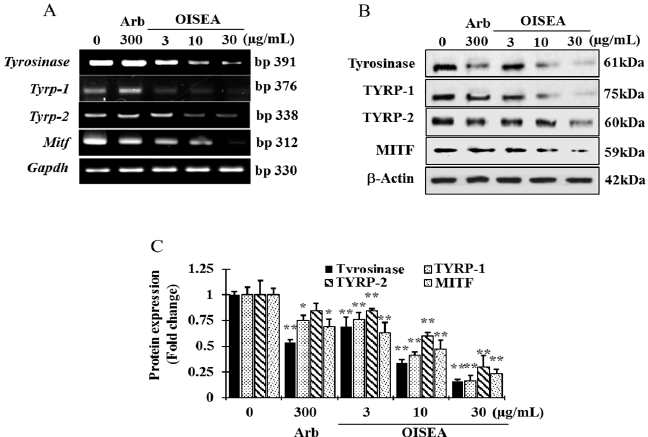
Figure 4. Effect of OISEA on the levels of melanogenesis related mRNA and proteins in melan-a cells. ( A ) Cells (5 × 10 5 cells/mL) were cultured for 24 h; the medium was replaced with fresh medium containing the indicated concentration of OISEA or arbutin for 24 h, and the mRNA was extracted using TRIzol. mRNA expression was analyzed by reverse transcription-polymerase chain reactions. ( B ) Cells (5 × 10 5 cells/mL) were cultured for 24 h; the medium was replaced with fresh medium containing the indicated concentrations of OISEA or arbutin for 3 days. Total cell lysates were extracted and assayed by Western blotting using antibodies against tyrosinase, TYRP-1, TYRP-2, and MITF. Equal amounts of protein loading were confirmed using β -actin. ( C ) Statistical analysis of the band intensity of tyrosinase, TYRP-1, TYRP-2, and MITF obtained by Western blot analysis. Results are presented as means ± SD. * p < 0.05, ** p < 0.01, versus the non-treated group.